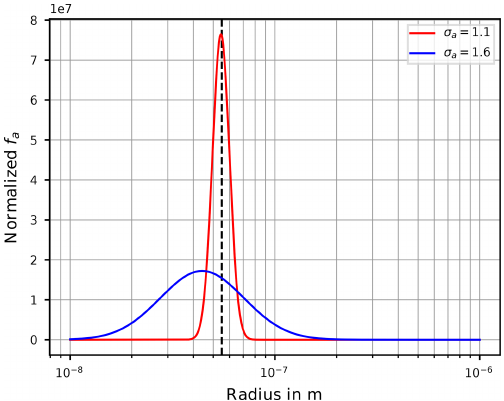
Figure C1. Two lognormal size distributions based on Eq. (13) with N a = 1. The size distributions share the value r a = 55nm for the ge- ometric mean radius (indicated by the vertical dashed line) but fea- ture different choices for the geometric width σ a = 1 . 1 (red curve) and σ a = 1 . 6 (blue